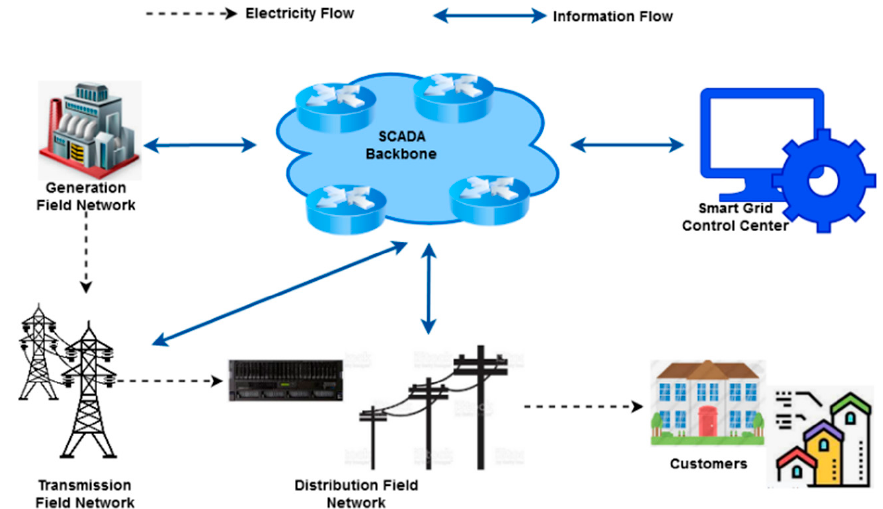
Figure 1. Smart grid SCADA network.